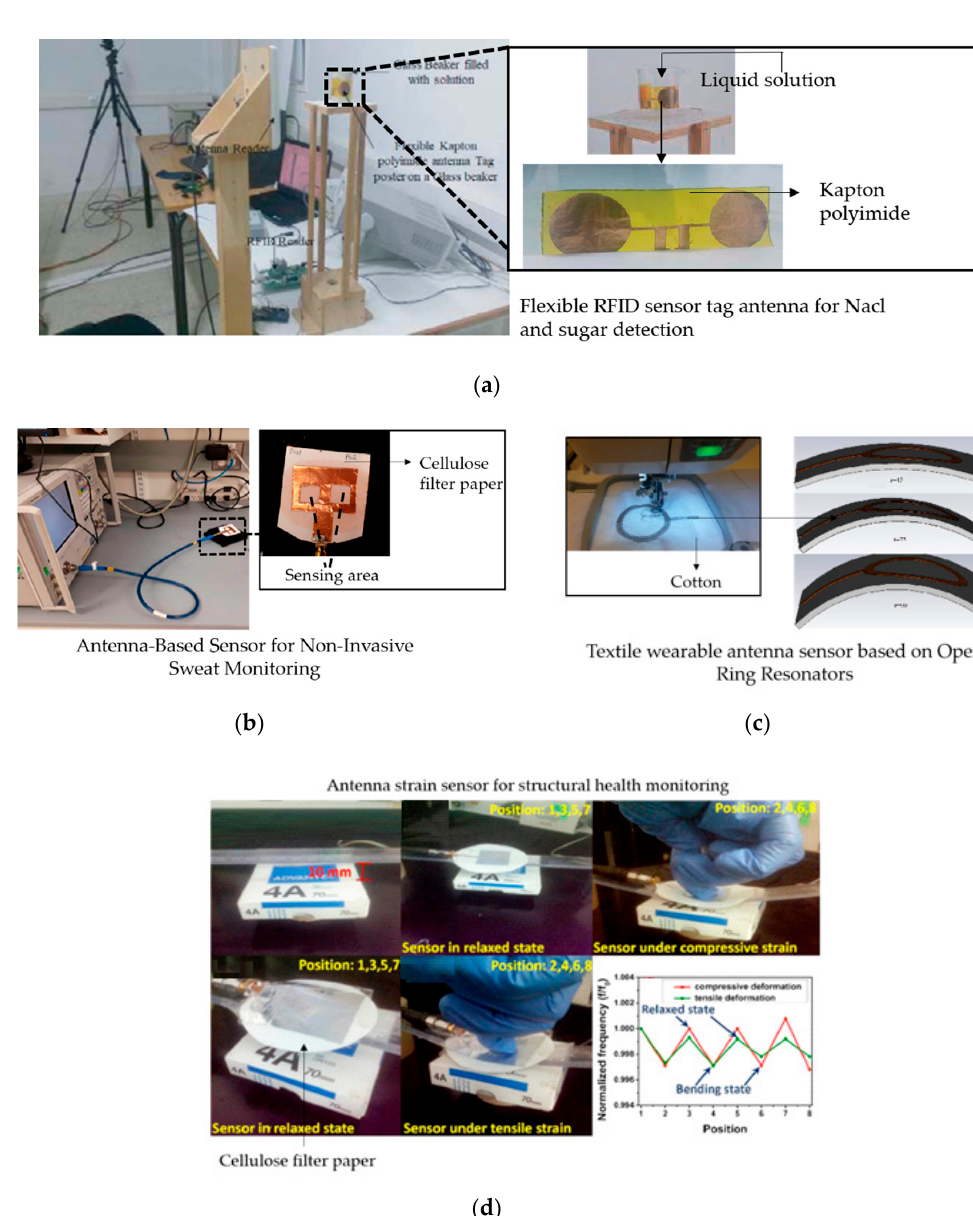
Figure 9. ( a ) Experimental setup for the measurements of the concentration of aqueous solutions, reproduced by courtesy of The Electromagnetics Academy [99]; ( b ) antenna sensor photo after absorbing saline solution [93]; ( c ) antenna sensor under bending stress, reproduced with permission from [101]; and ( d ) photographs of an antenna sensor in state tensile strain and compressive, reproduced with permission from [96].